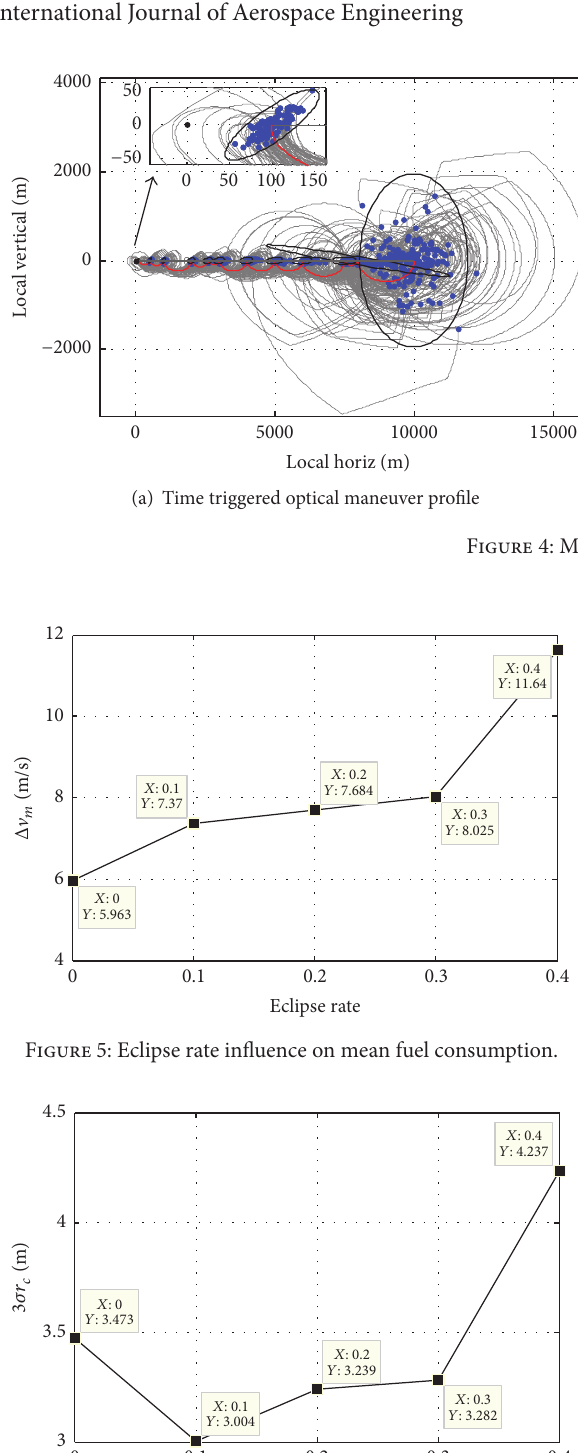
= 3.477% of range, under a 30% data gap per revolution on account of the